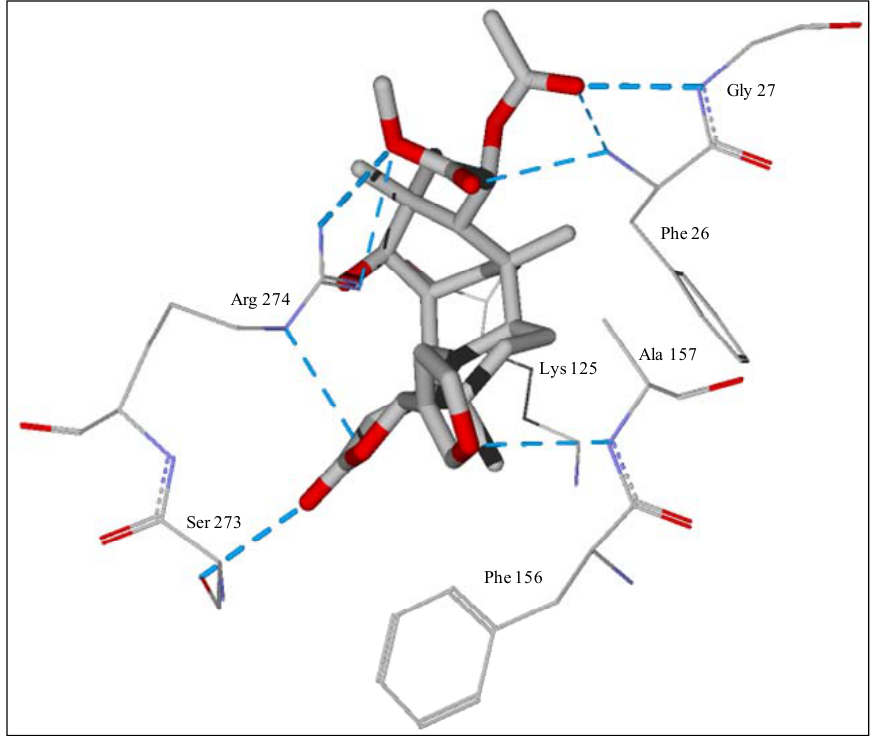
Figure 26. Lowest-energy docked pose of 6- O -acetylswietenolide with L. mexicana glycerol-3-phosphate dehydrogenase (LmexGPDH, PDB 1n1e) showing key interactions with Arg 274, Ser 293, Phe 26 and Ala 157, and Gln 139. Hydrogen-bonds are shown as blue dashed lines.